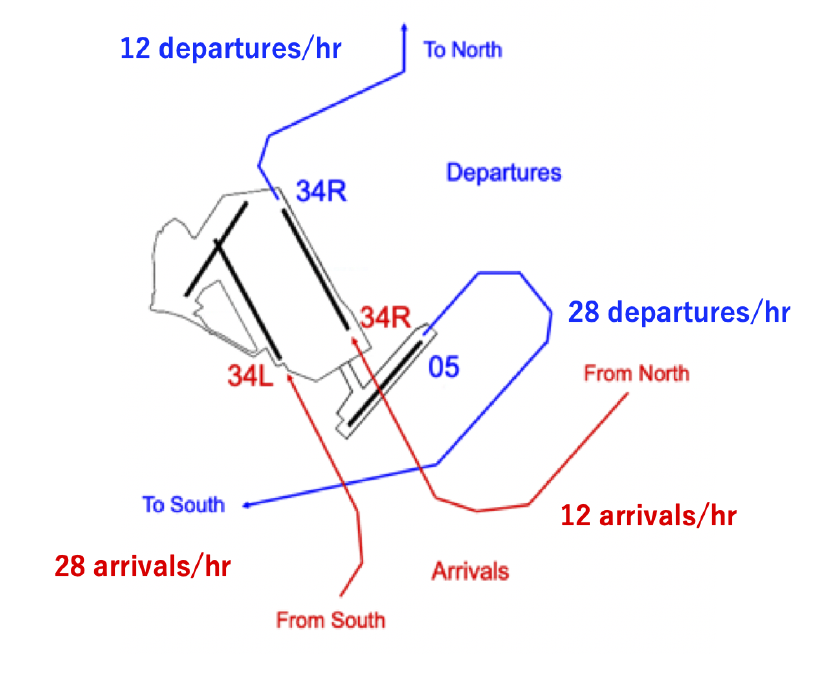
Figure 2. RJTT northerly wind